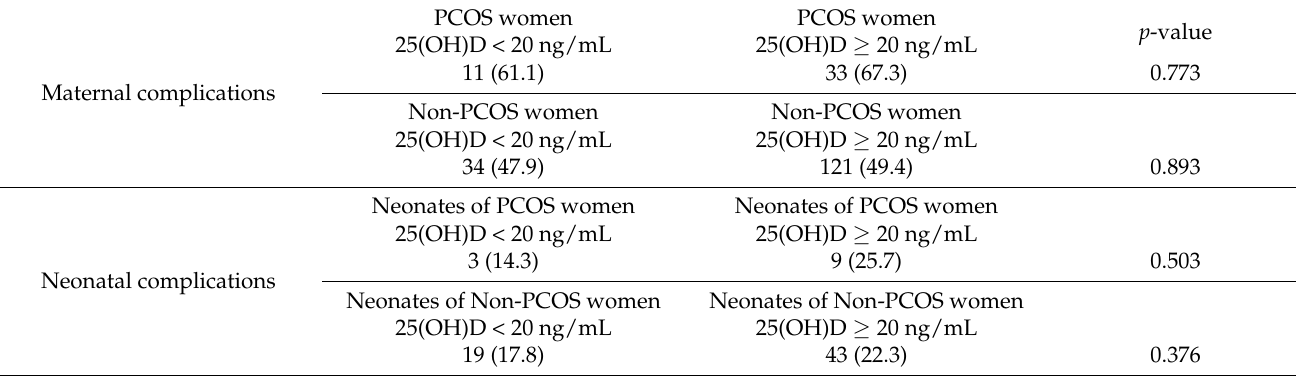
Table 3. Association between 25(OH)D deficiency and maternal and neonatal complications in PCOS and Non-PCOS